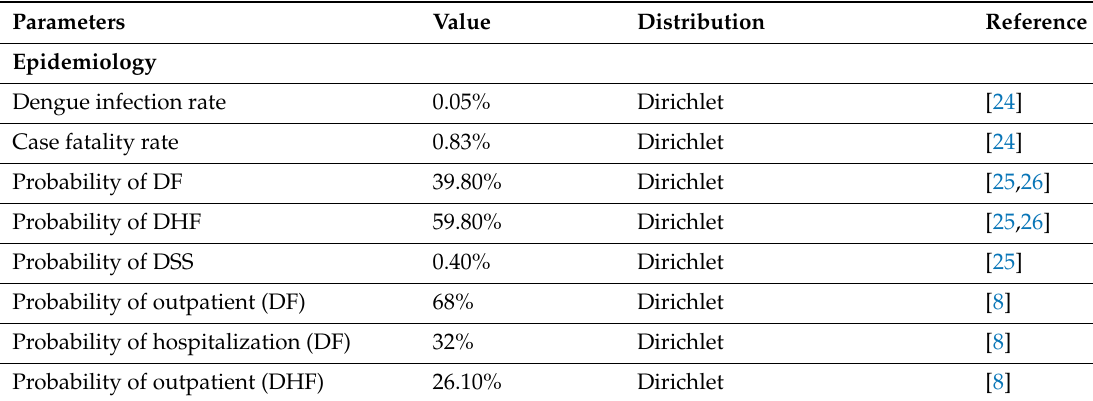
Table 1. Parameters used in the